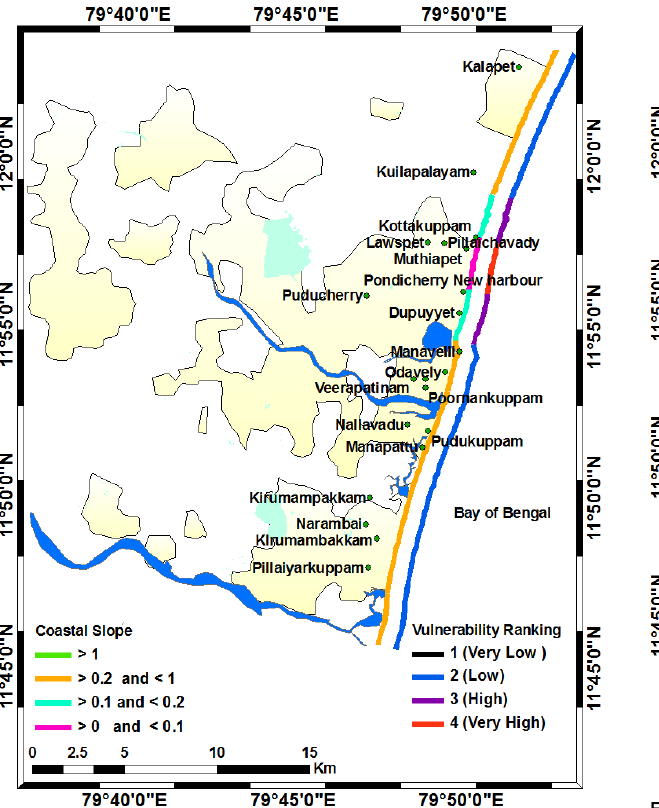
Fig. 4. Vulnerability ranking map of